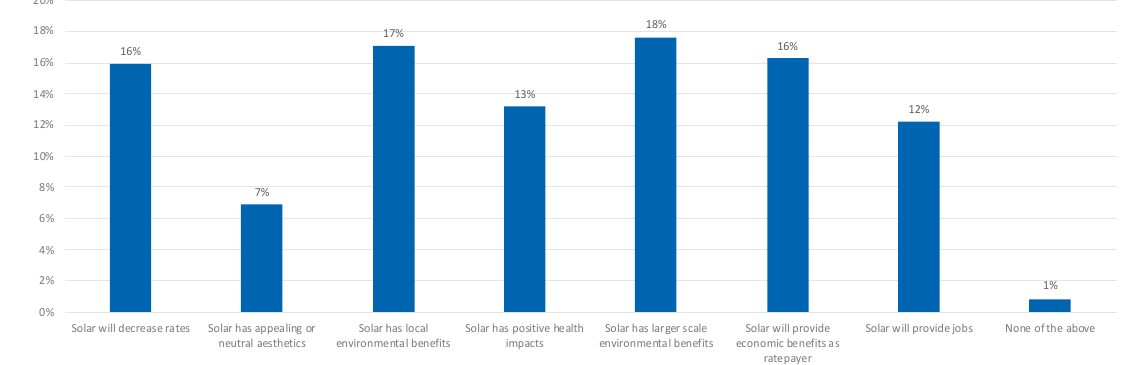
Figure 8. Reasons to Support Solar Development.